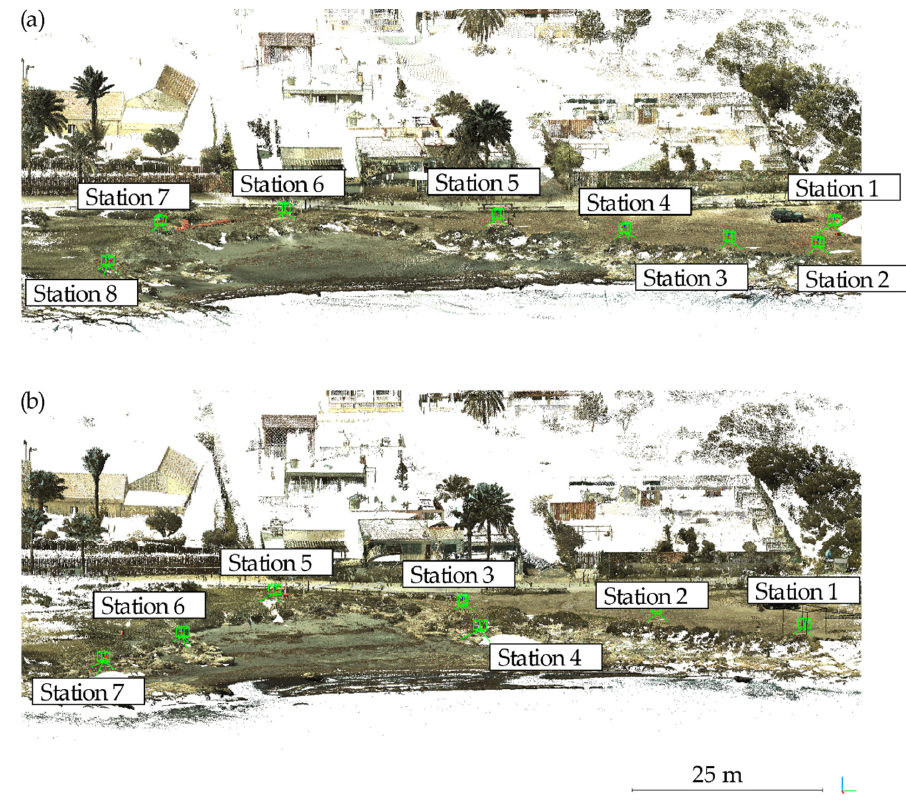
Figure 2. ( a ) 3-D point cloud of the scenario/sampling date A (24 November 2016) and location of the scan stations; ( b ) 3-D point cloud of the scenario/sampling date B (22 March 2017) and location of the scan stations.